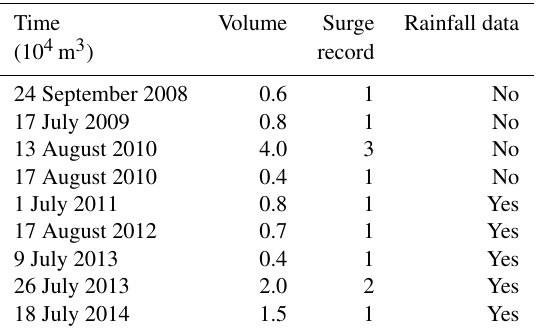
Table 3. The specific conditions of debris flow events in the Guo- juanyan gully after the